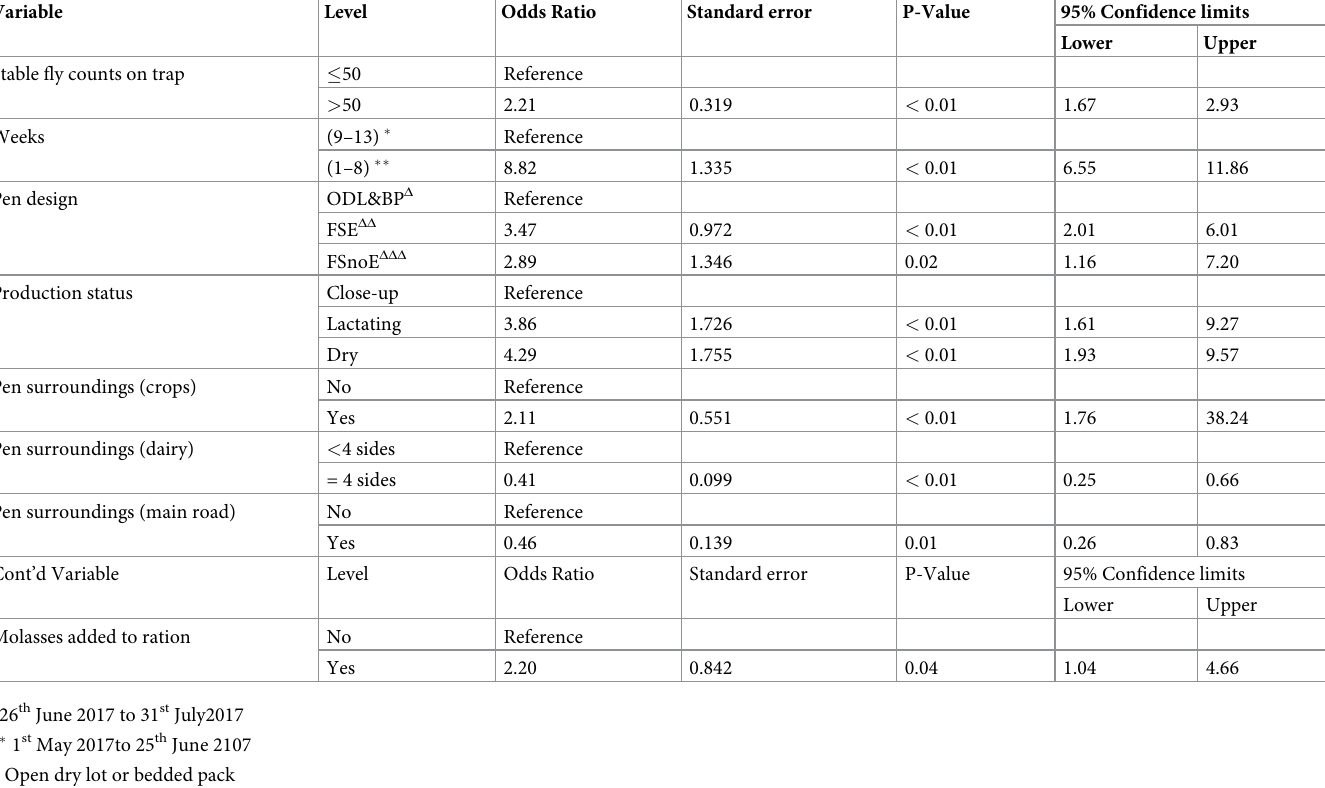
Table 3. Final generalized linear mixed model with logit link predicting cow bunching at the pen level (331 pens) using Stable fly counts on traps placed on 20 Cali- fornia dairies.